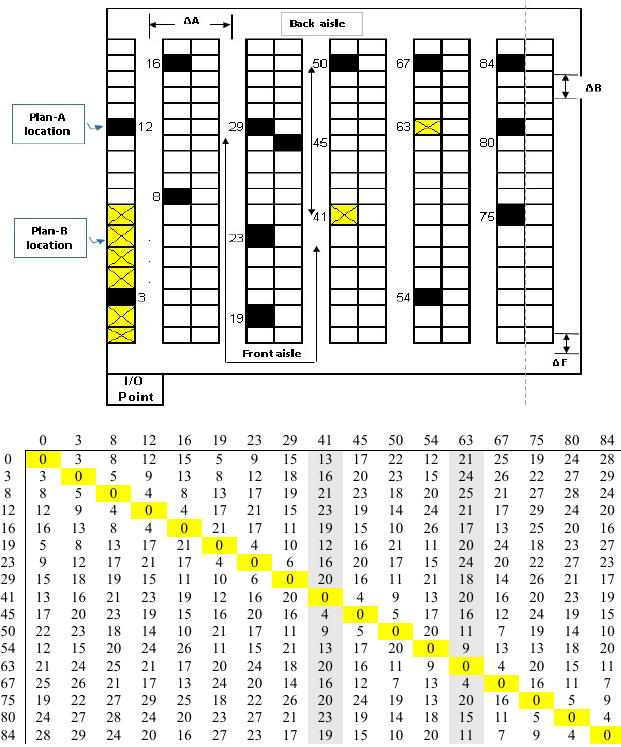
Figure 5. Location distribution on the proposed